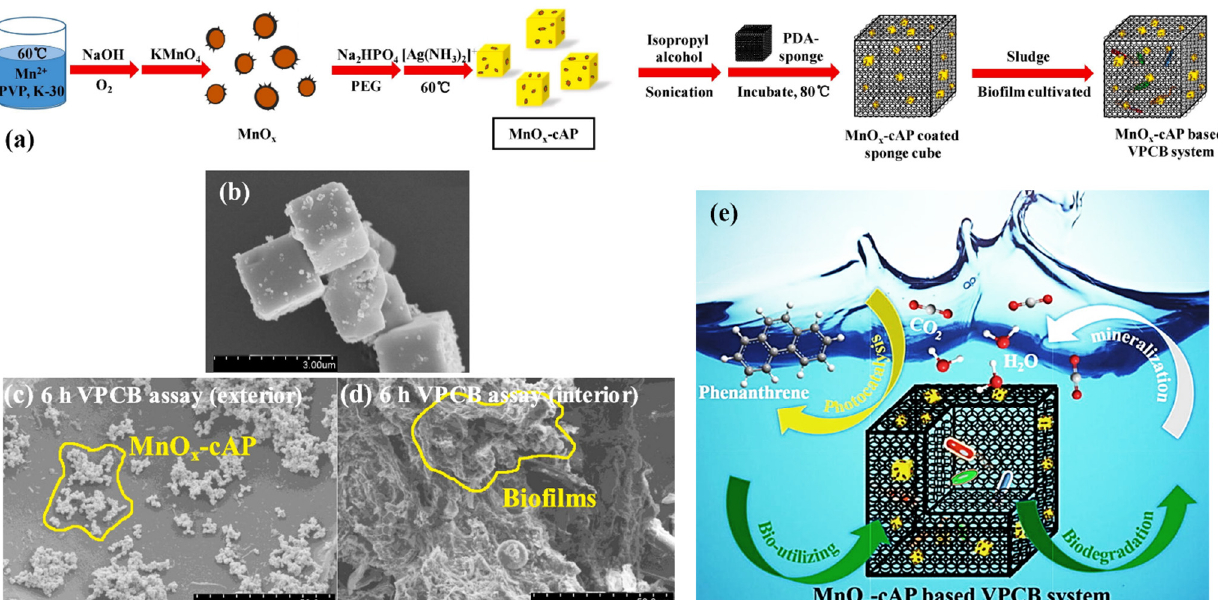
Figure 15. Sketch of the preparation of MnO x on Ag 3 PO 4 cubes (MnO x -cAP), followed by coating on polyurethane sponge ( a ); SEM micrograph of the MnO x -cAP isolated ( b ) and coated ( c ), along with the biofilm ( d ); scheme of the coupled visible light photocatalysis and biodegradation (VPCB) process ( e ). Adapted with permission from [211], Copyright (2019), Elsevier.